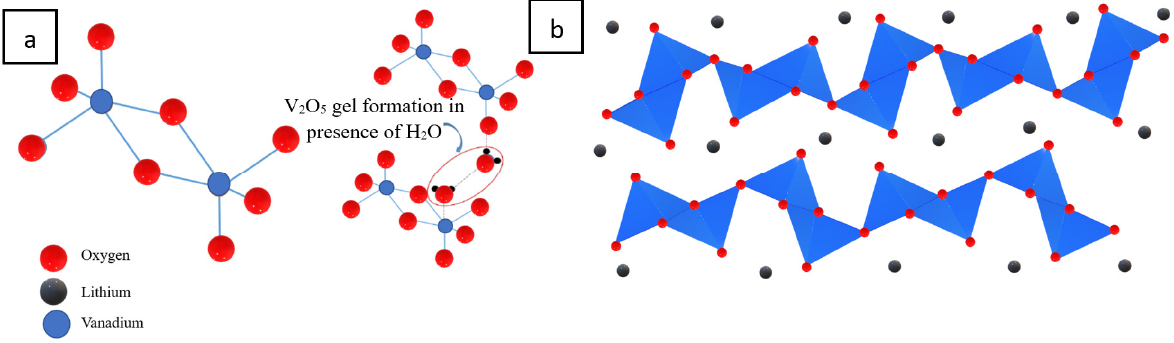
Figure 1. ( a ) Vanadium pentoxide (V 2 O 5 ) chemical structure during gel formation and ( b ) the crystalline structure of lithiated Li x V 2 O 5.